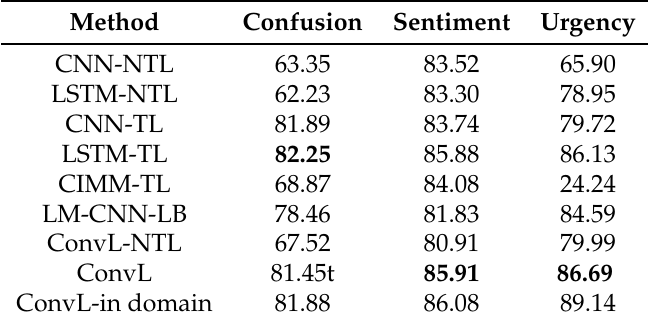
Table 3. Experimental results from different methods (accuracy %). CIMM, consumption intention mining